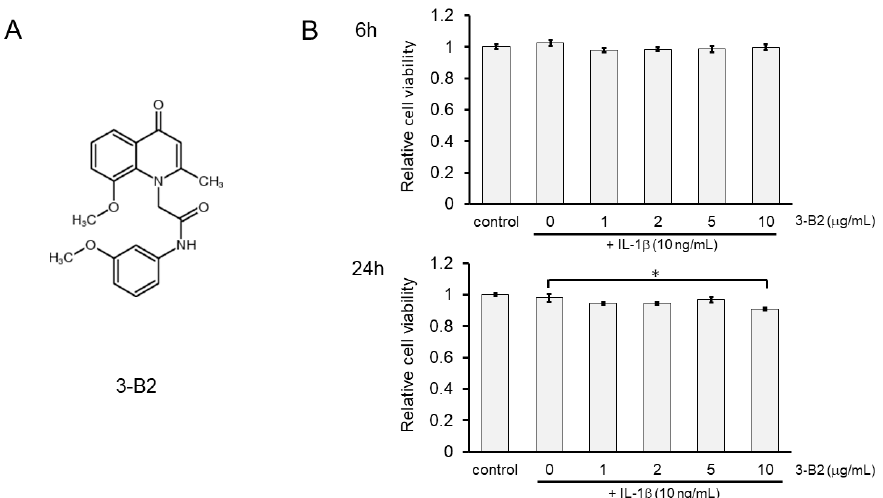
Figure 5. Effect of 3-B2 on the cell viability of OUMS-27 cells and IL-1 β -induced damage. ( A ) Struc- ture of the selected compound, 3-B2. ( B ) Relative cell viability determined by MTS assay shows pretreatment with 3-B2 at 1–10 μ g/mL concentrations did not have significant cytotoxic effects on OUMS-27 cells after 6 h of IL-1 β -stimulation, while 3-B2 pretreatment (24 h) at 10 μ g/mL with longer IL-1 β stimulation (24 h) has moderate cytotoxic effects on OUMS-27 cells. Values represent mean ± SE ( n = 6 per group). * p < 0.05.